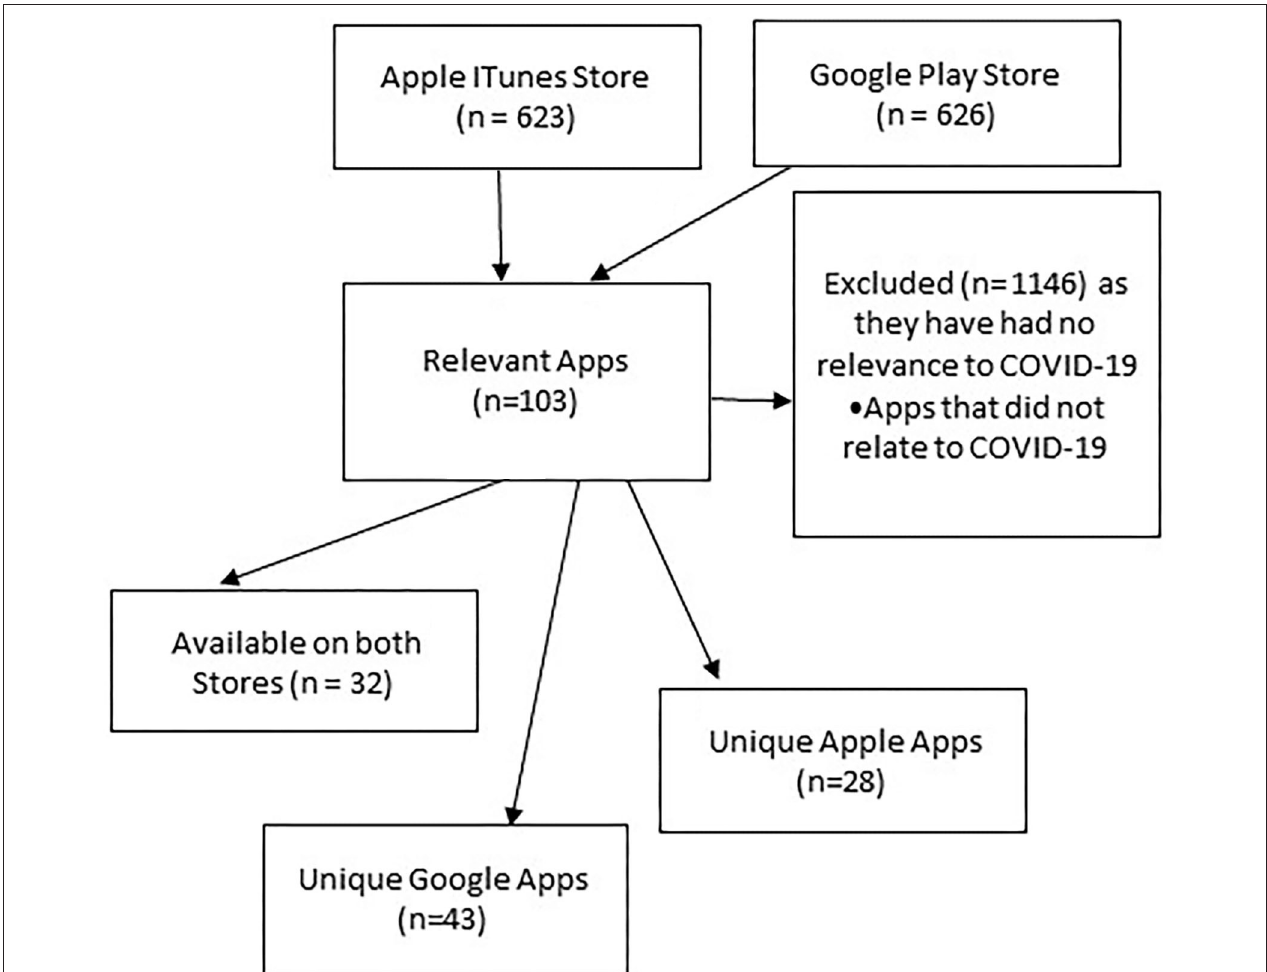
FIGURE 1 | Flowchart demonstrating how applications were